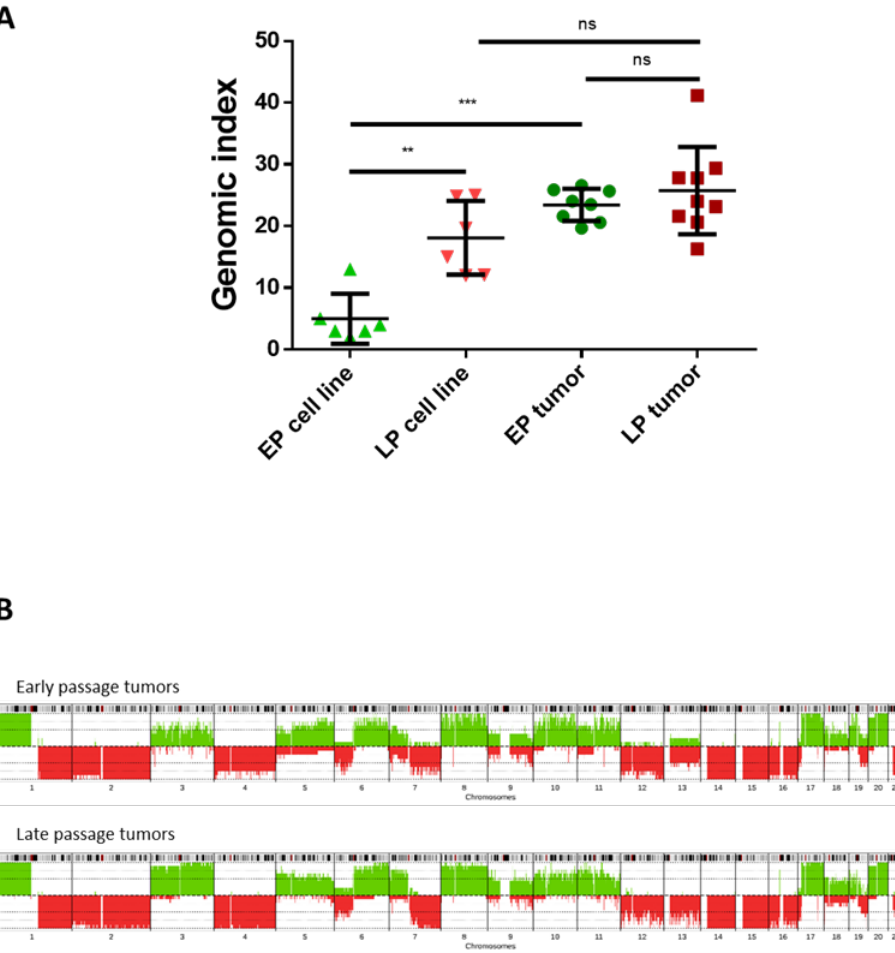
Figure 4. LP cell lines do not evolve in vivo whereas EP tumors display more chromosomic rearrangements than EP hybrids. ( A ) Comparison of genomic index between cell lines at EP and LP and their matching tumors. ns p > 0.05; ** p < 0.01; *** p < 0.001 Mann-Whitney test. ( B ) CNV frequencies (penetrance plot) in early (top) and late passage tumors (bottom). x -axis represents all chromosomes, y -axis represents proportion of tumors harboring chromosomal gains (green) and losses (red).